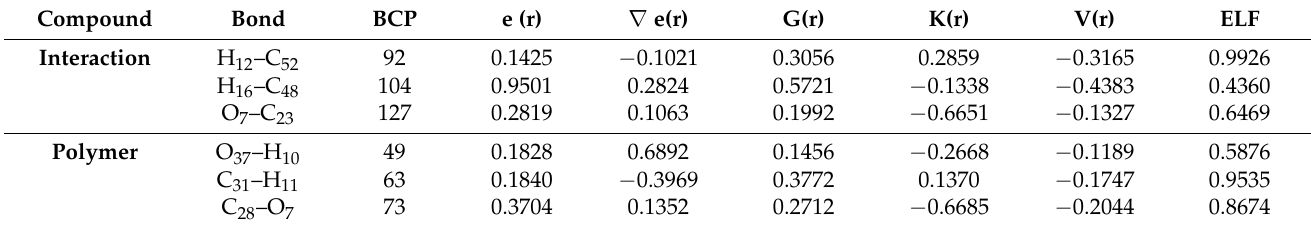
Table 3. The properties of the topology analysis.